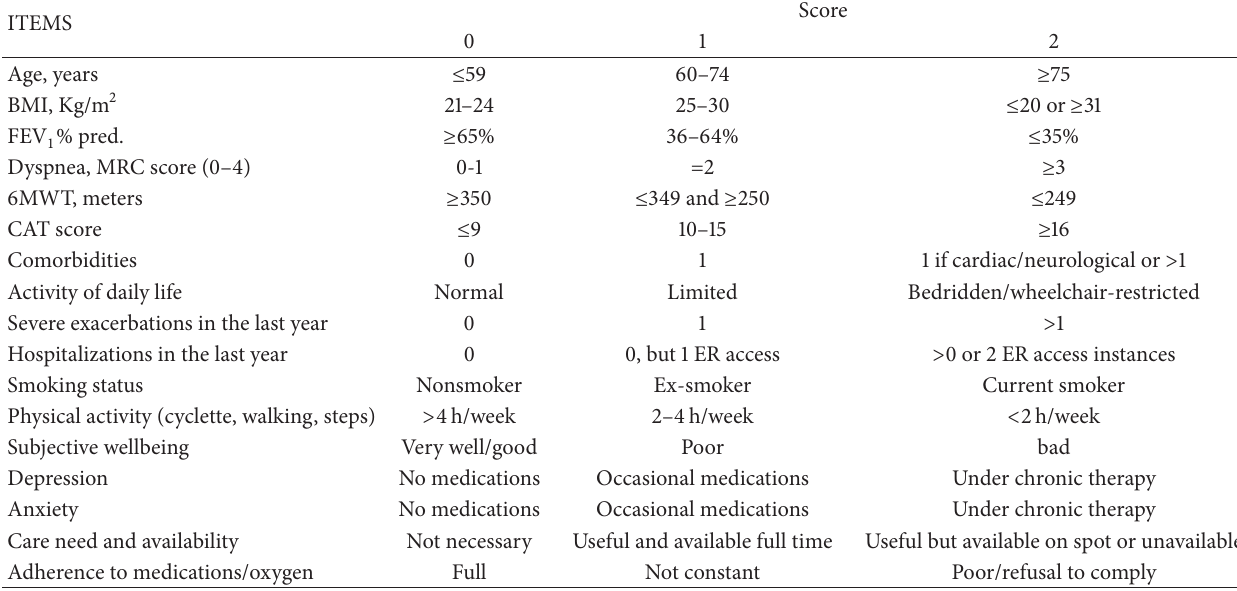
Table 1: Pulmonary Rehabilitation Decisional Score (PRDS).